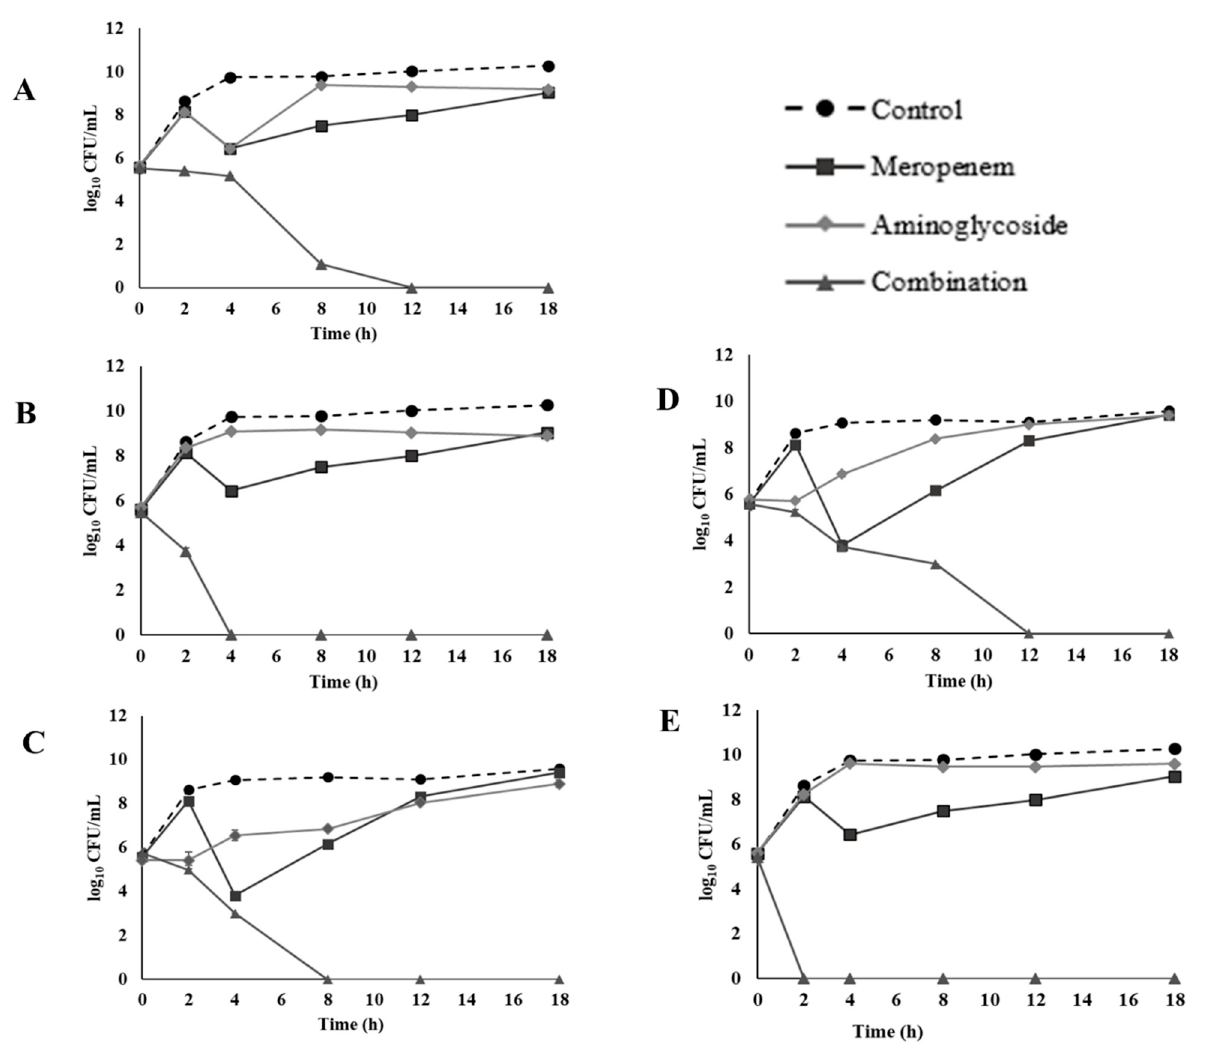
Figure 1. Time-kill curves of 1/4 MIC (32 µg/mL) meropenem and 1/4 MIC aminoglycosides combination against CREC 12: ( A ) amikacin (256 µg/mL), ( B ) gentamicin (256 µg/mL), ( C ) kanamycin (256 µg/mL), ( D ) streptomycin (8 µg/mL), and ( E ) tobramycin (256 µg/mL).